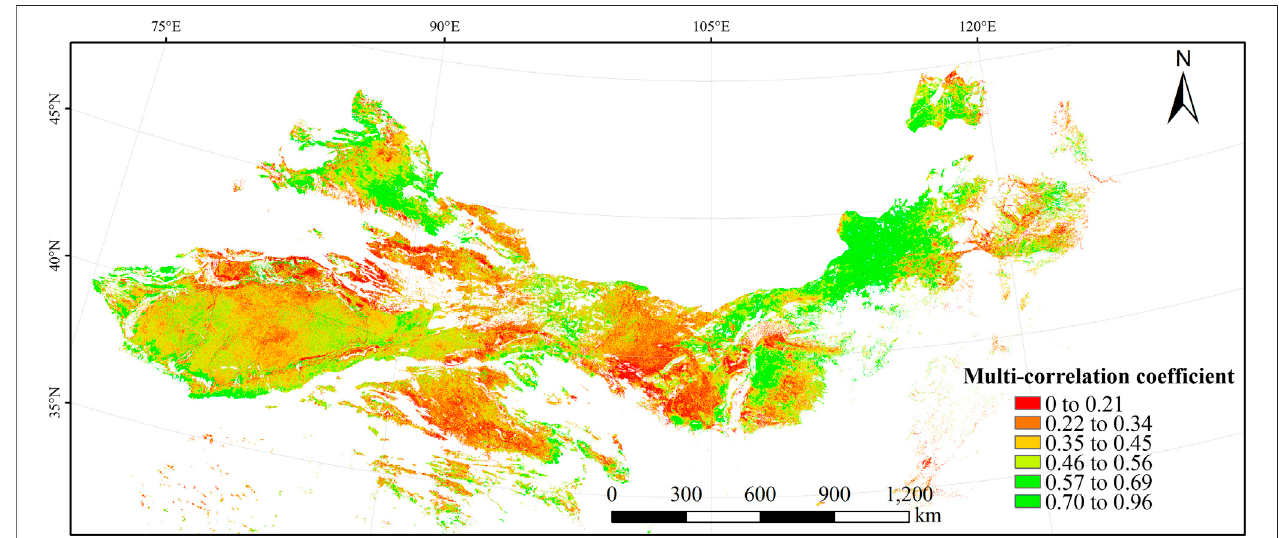
FIGURE9| Spatialdistributionofthemultiple-correlationcoef fi cientbetweenthemulti-yearmeannormalized-differencevegetationindex(NDVI)from1998to2015 and the two climate drivers (temperature and precipitation) for the same period in the desert area of northern China.